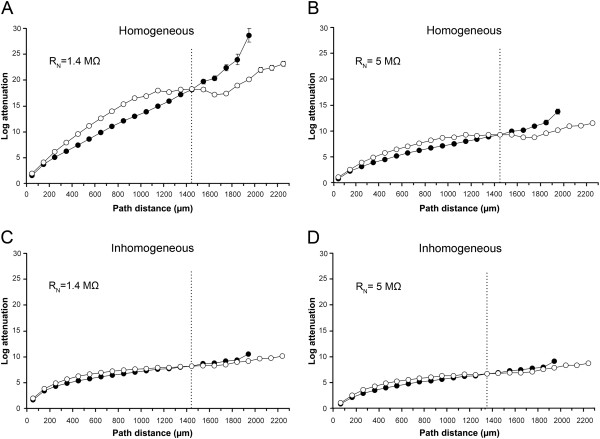
Comparison of somatopetal log attenuations of postsynaptic potentials. Attenuations of PSPs were computed from dendritic locations and averaged within 100 μm path distance ranges from the soma. Homogeneous (Rms = Rmd, part A and B) and inhomogeneous (Rms < Rmd, part C and D) soma-dendrite membrane models were used with 1.4 MΩ (A and C) and 5.0 MΩ (B and D) neuron resistances, where Rms and Rmd values were defined as described in the legend of Figure
7. A characteristic 1400–1500 μm distance, the limit of distance domains where attenuations in cervical (closed circles) and lumbar MNs (open circles) were significantly different were marked by vertical dotted lines. Many error bars are not visible due to their very low values.